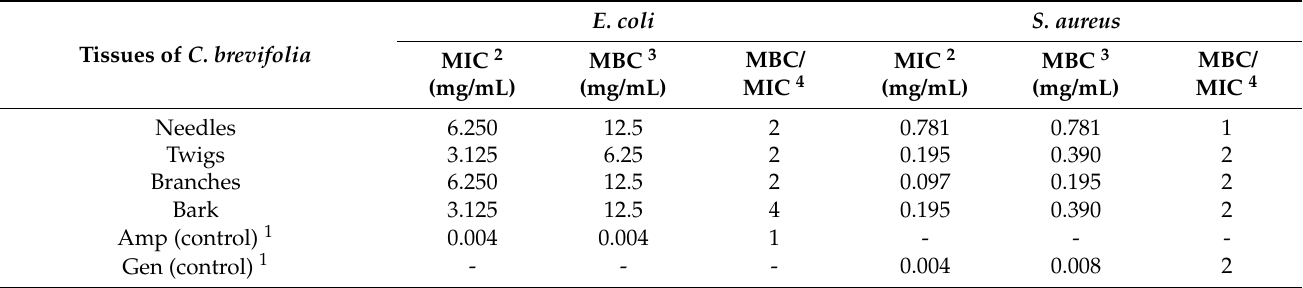
Table 4. Minimum inhibitory concentration (MIC), minimum bactericidal concentration (MBC), and ratio MBC/MIC of C. brevifolia methanol extracts against E. coli (Gram-negative) and S. aureus (Gram-positive)